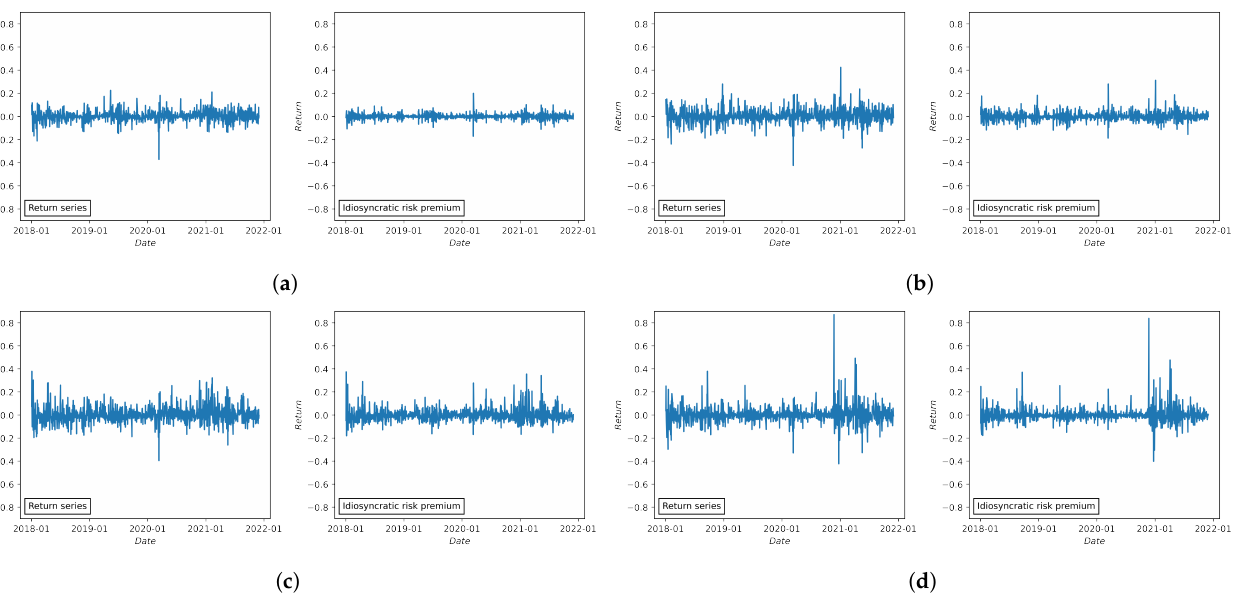
Figure 3. Daily return series and idiosyncratic risk premium of each cryptocurrency. ( a ) BTC. ( b ) ETH. ( c ) ADA. ( d )